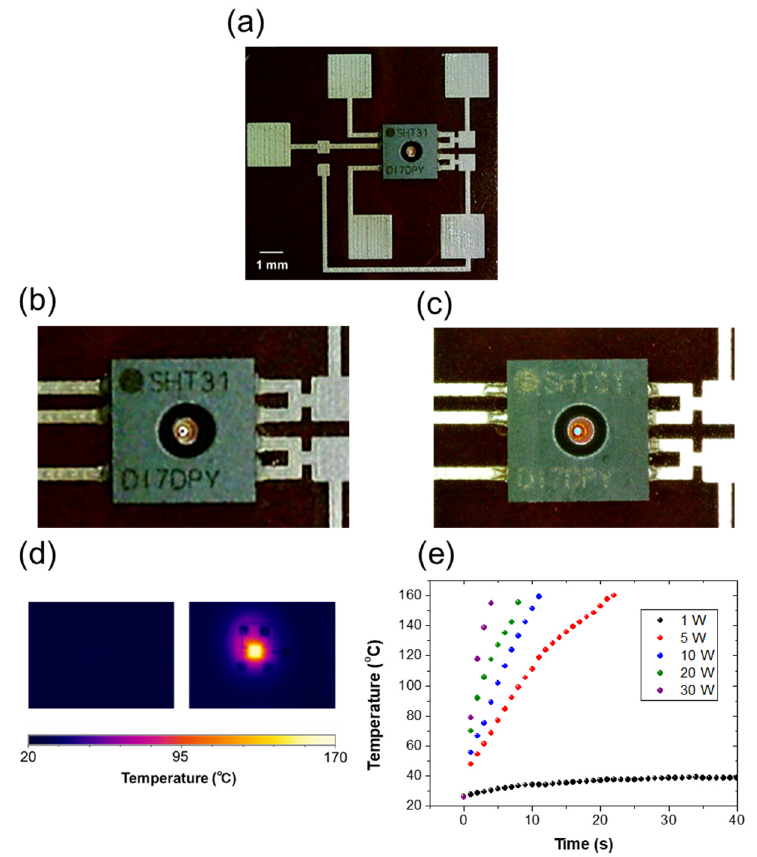
Figure 9. ( a ) Image of a thermo-sensor. Photographs of a sensor and connection part ( b ) before and ( c ) after MW irradiation at 10 W of output power. ( d ) Thermography of samples by MW irradiation with 10 W of output power for 10 s. ( e ) Temperature properties by MW irradiation with 1 (black circle), 5 (red circle), 10 (blue circle), 20 (green circle), and 30 W (purple circle) output powers for 40, 22, 11, 8, and 4 s, respectively. Table 1. Room temperate measured by digital meter and